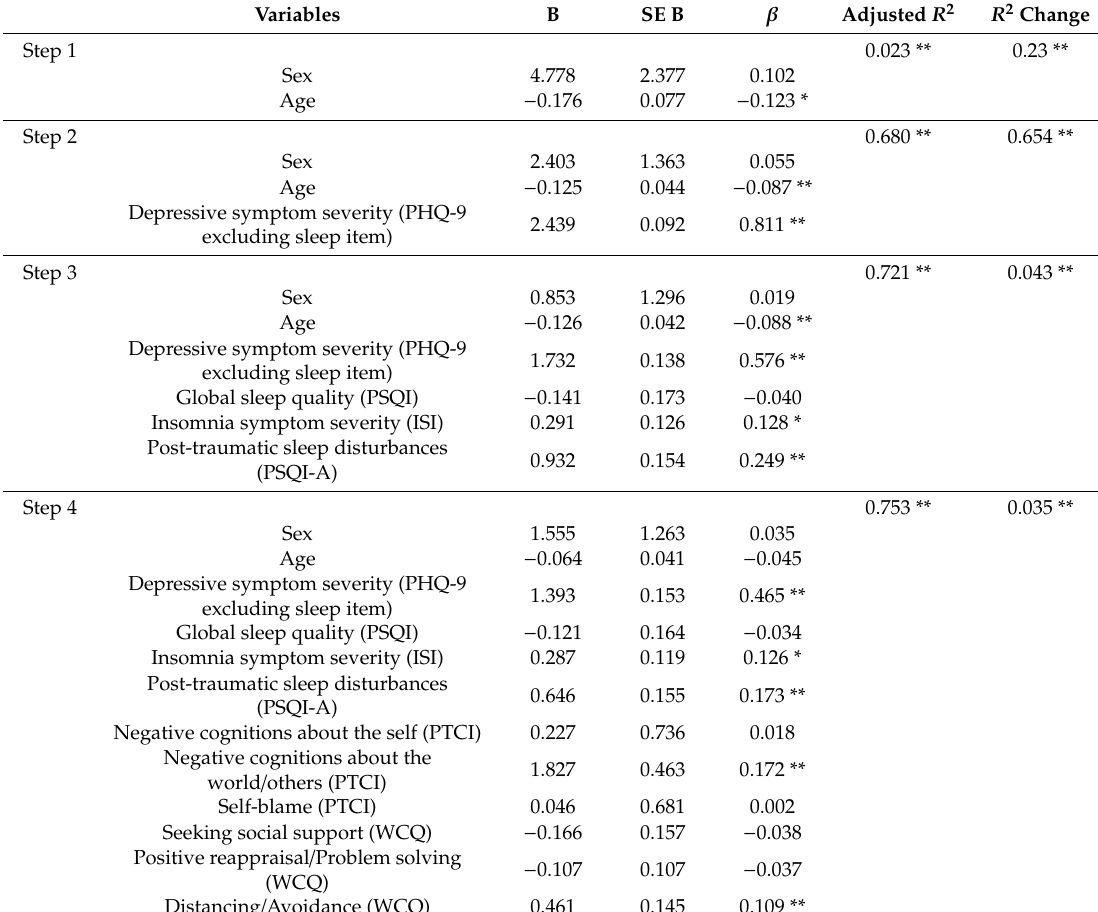
Table 5. Multiple regression analyses predicting PTSD symptom severity (excluding sleep items) ( n =